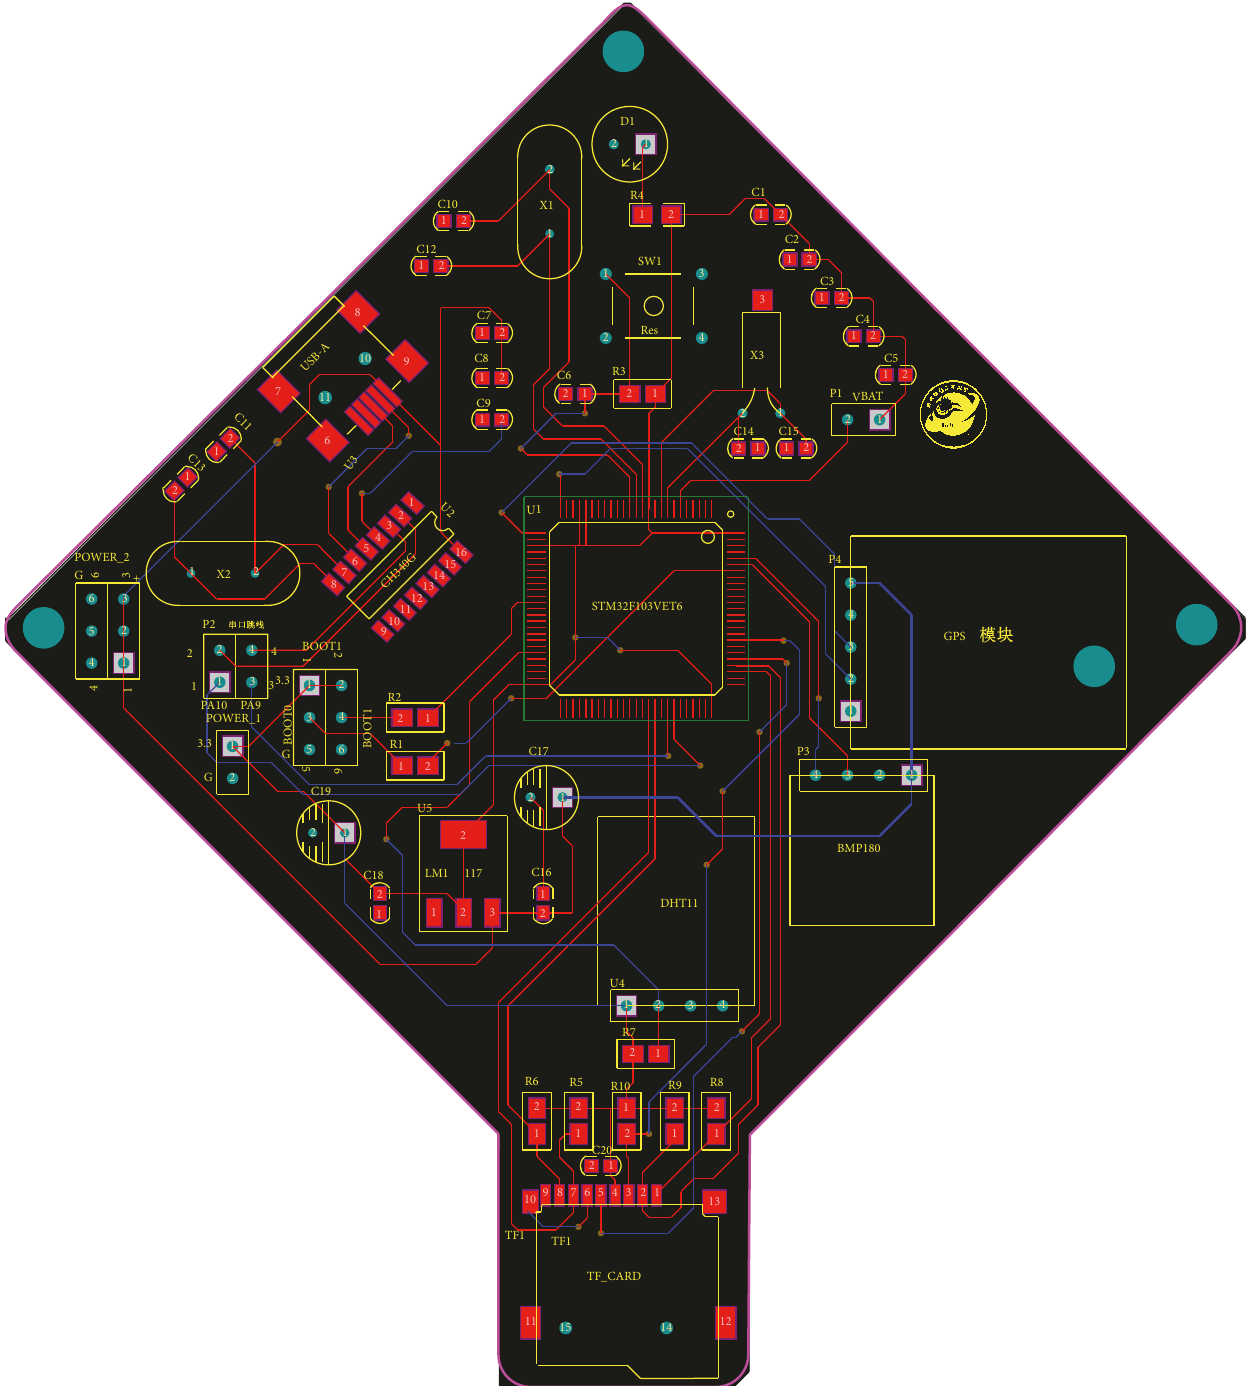
Figure 13: PCB wiring